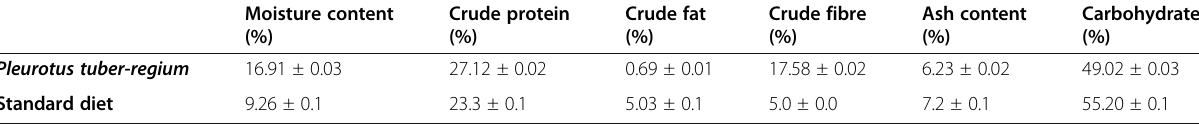
Table 4 Proximate composition of Pleurotus tuber-regium and Standard diet (Control feed) (g/100 g)